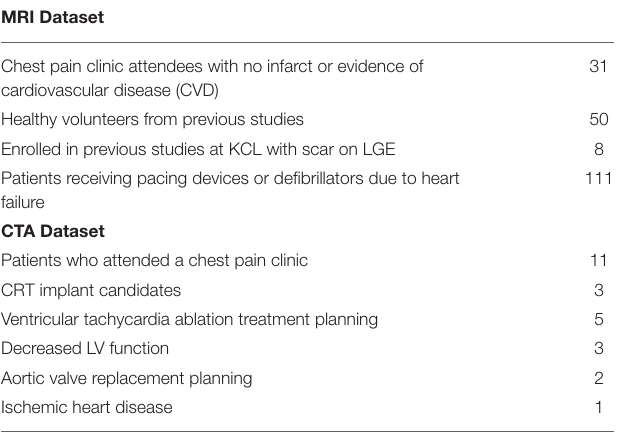
TABLE 2 | Breakdown of indication for imaging in both magnetic resonance imaging (MRI) and computed tomography angiography (CTA) datasets. MRI Dataset